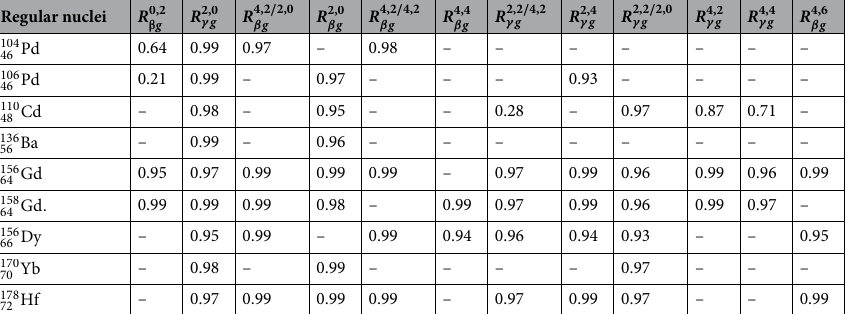
Table 1. The ratio of quadrupole transition rates in regular